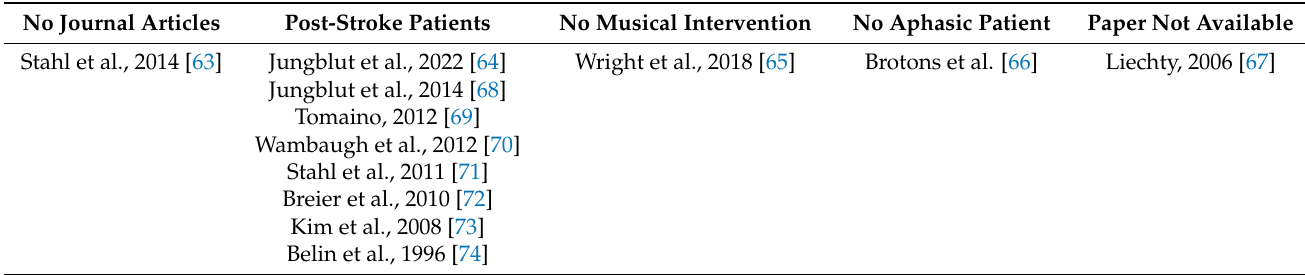
Table 1. Main characteristics of the studies excluded from this